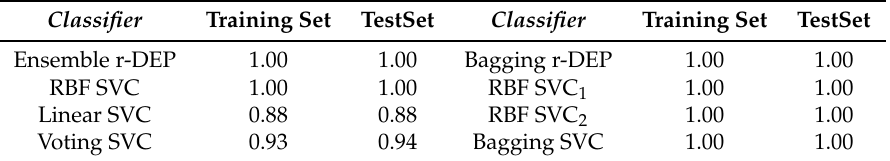
Table 2. Accuracy score of the classifiers considered in Example 7 on double-moon